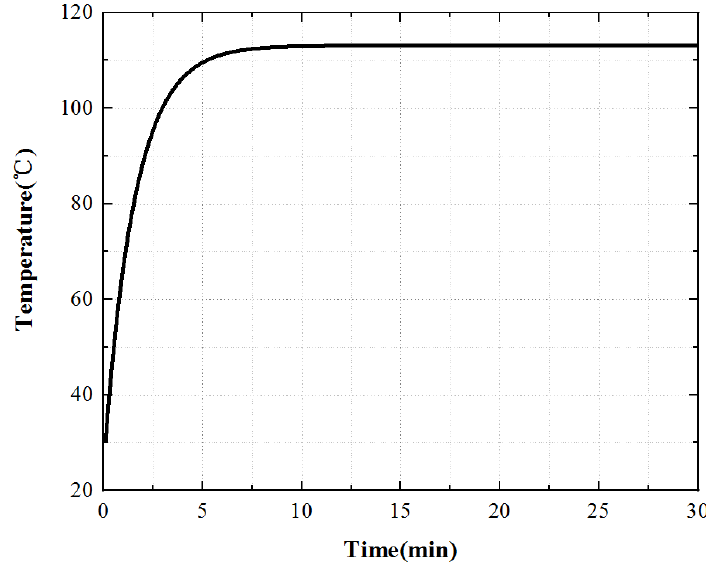
Figure 13. Temperature rise characteristic curve of the stator winding.